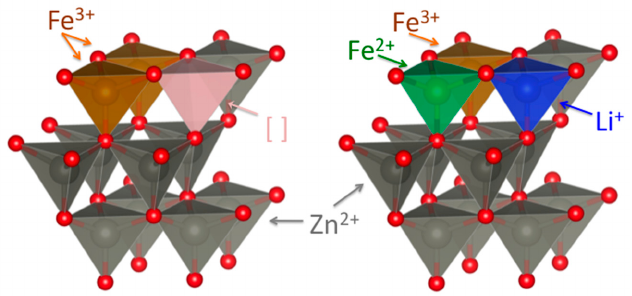
Figure 7. Schematic illustration of the cationic vacancies in the wurtzite lattice of the pristine material due to the Fe 3+ for Zn 2+ substitution ( left panel ) and the resulting initial lithium ion insertion in the vacant tetrahedral sites at higher potentials, leading to the partial reduction of Fe 3+ to Fe 2+ ( right panel ).